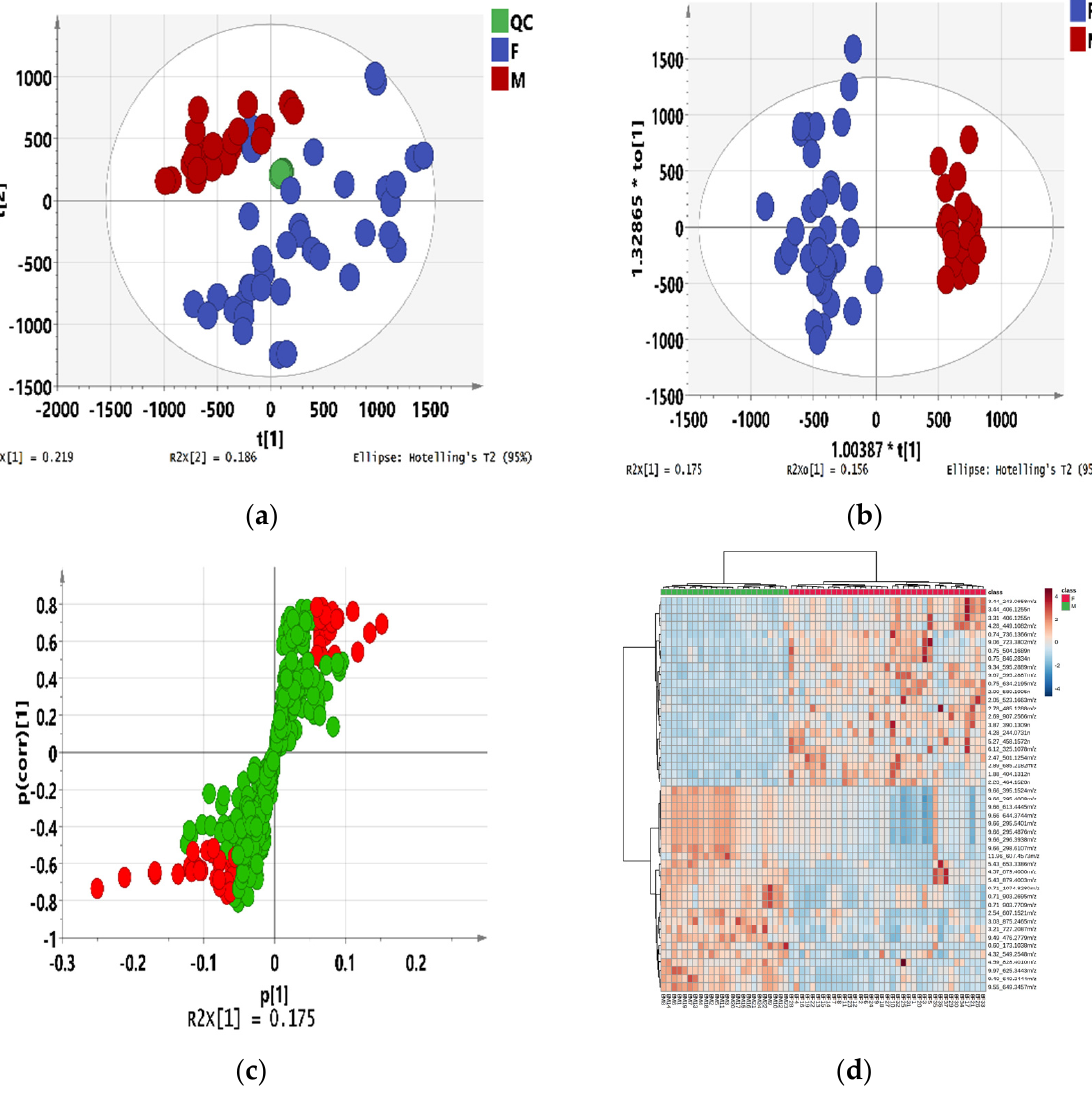
Figure 2. Chemometrics of male and female stem bark samples. ( a ) PCA score plot; ( b ) OPLS-DA score plot; ( c ) S-plot of OPLS-DA along with selected candidate differential metabolites (cut-off values of |p| ≥ 0.05 and |p(corr)| ≥ 0.5); ( d ) Heat-map and HCA analyses of metabolite contents in male and female stem bark samples.